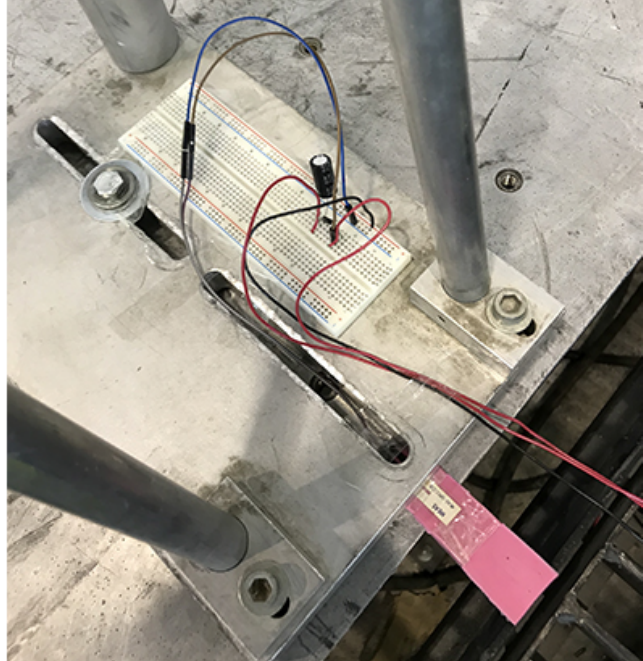
Figure 18. Experimental setup for energy harvesting: rubber plate and vibrating testing machine at the lab. Figure taken from [39].